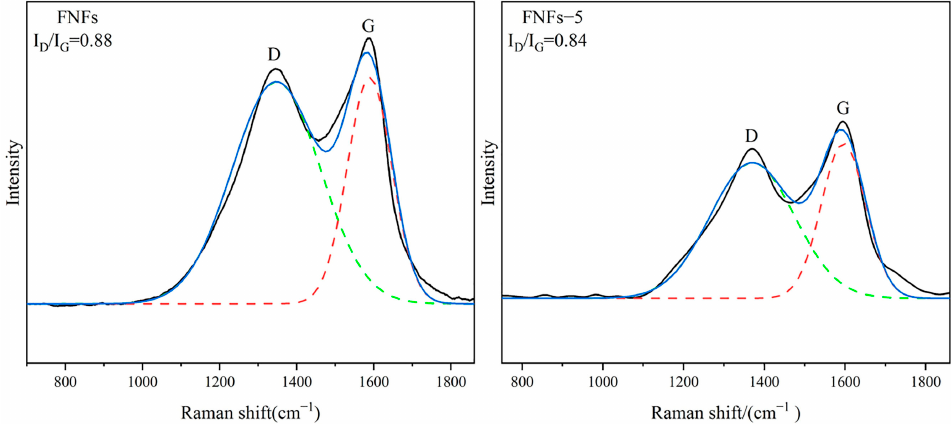
Figure 8. Raman spectra of the residual carbon of FNFs and